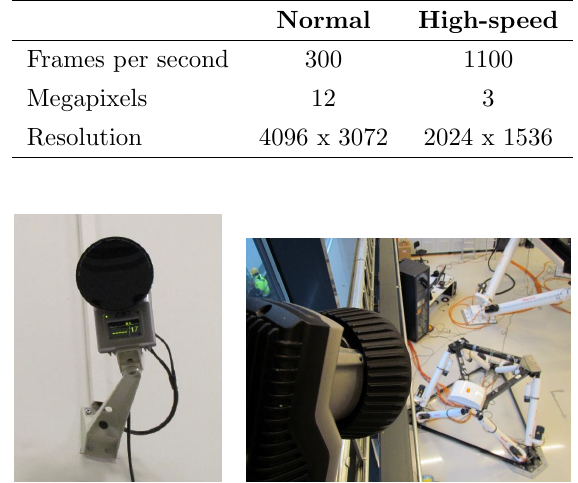
Figure 3: Qualisys motion-capture system, Oqus 700+ cameras installed in the Motion-Lab.